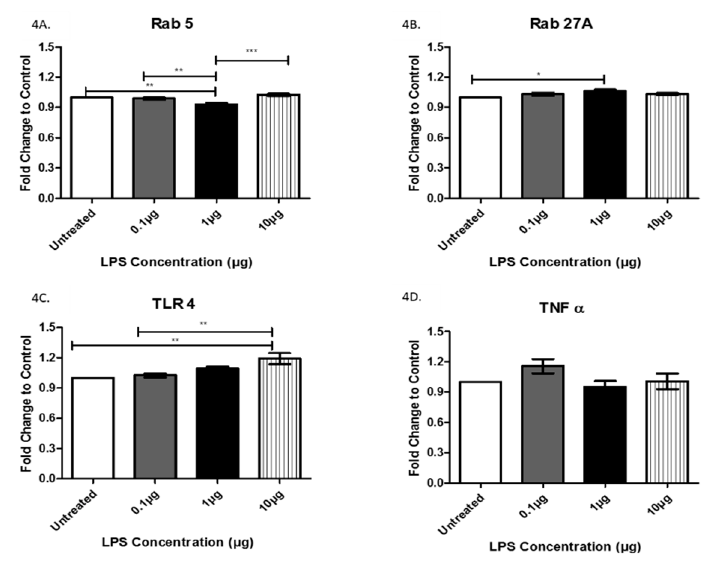
Figure 4. The expression of Rab5 ( A ), Rab27A ( B ), TLR4 ( C ), and TNF α ( D ) was determined by ELISA in exosomes from AC16 cells that were treated with different concentrations of LPS or left untreated. Data are shown as means ± SEM from a total of five experiments. Significance is indicated by * p ≤ 0.05 and ** p ≤ 0.01.